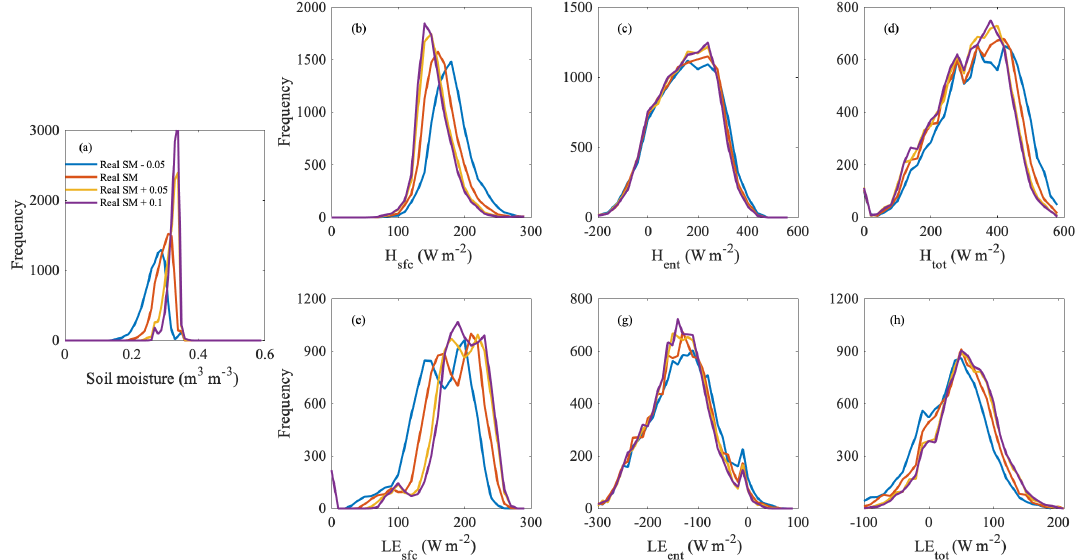
Figure 12. Frequency distribution of (a) mean soil moisture. (b–g) PBL energy budget components. Simulated using Noah-BouLac with different initial soil moisture conditions.